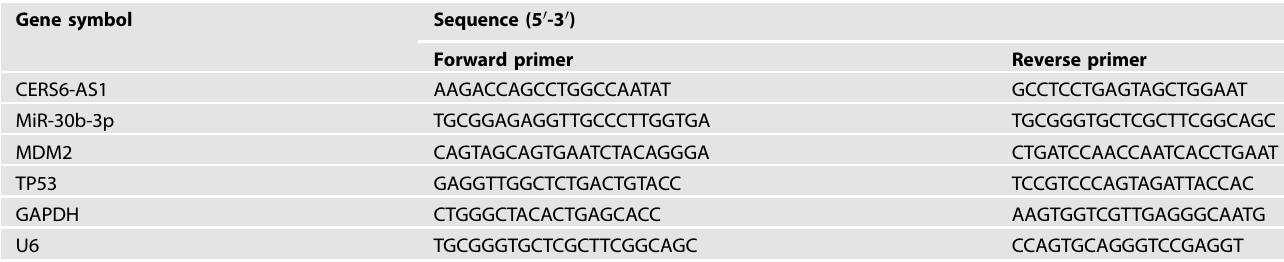
Table 1. The primer of genes involved in this